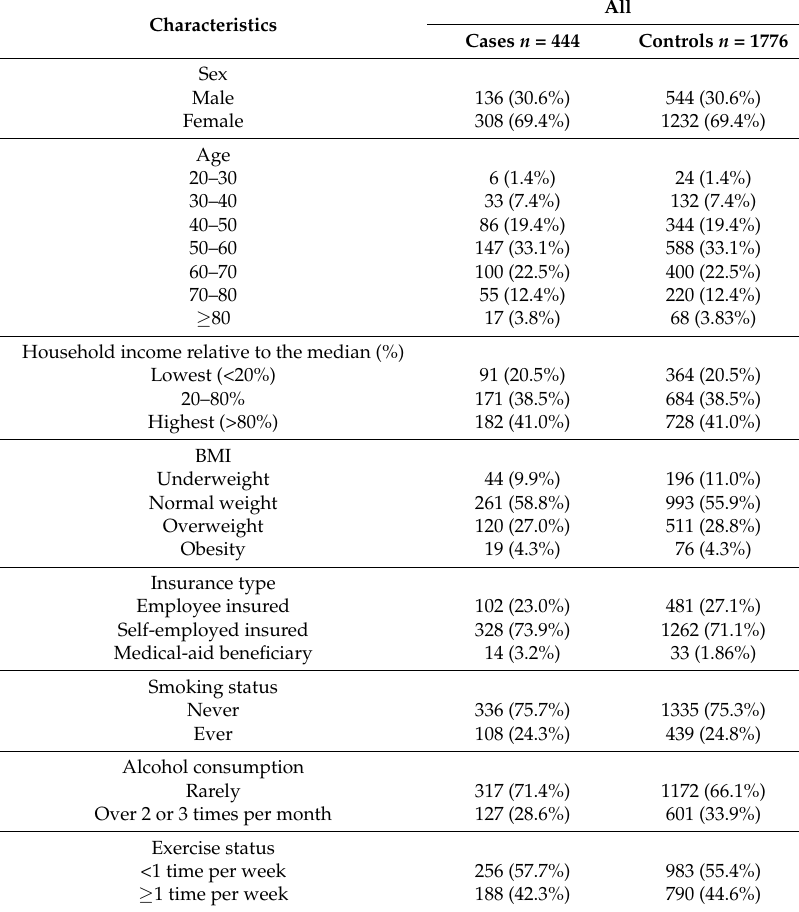
Table 1. Descriptive characteristics of the study participants ( n = 2220) in 2015.